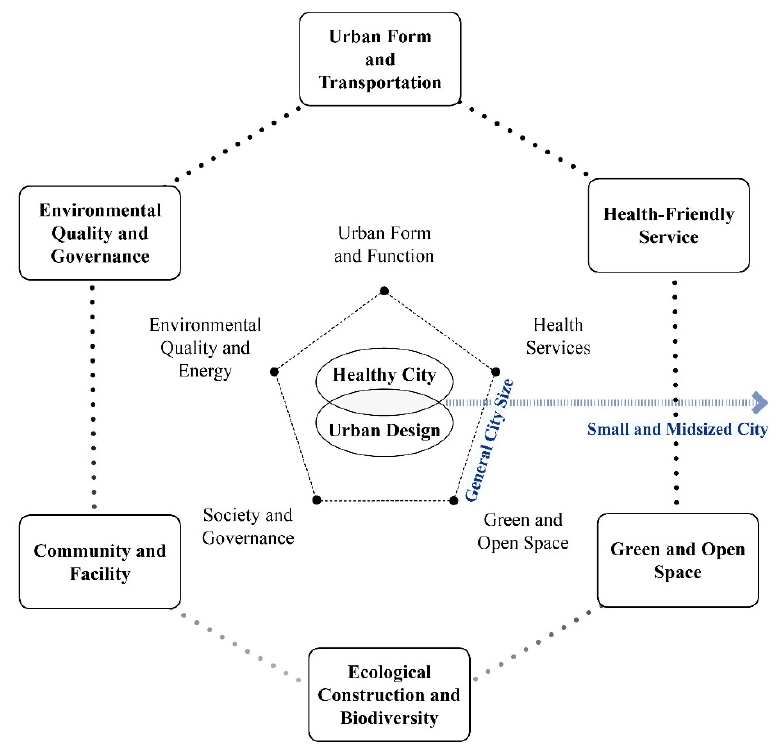
Figure 2. Conceptual framework development. Table 2. Mean values, factor loading, percentage of variance explained, and cumulative percentage of the variance of all variables.